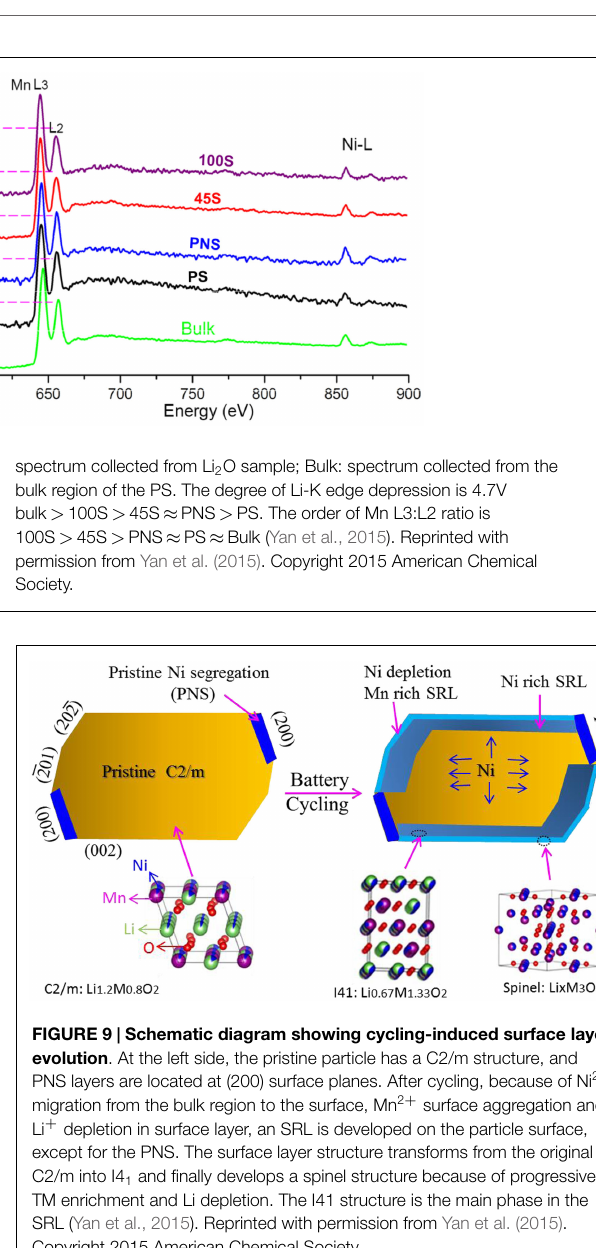
(200) planes is shown. After cycling, a thin SRL is developed